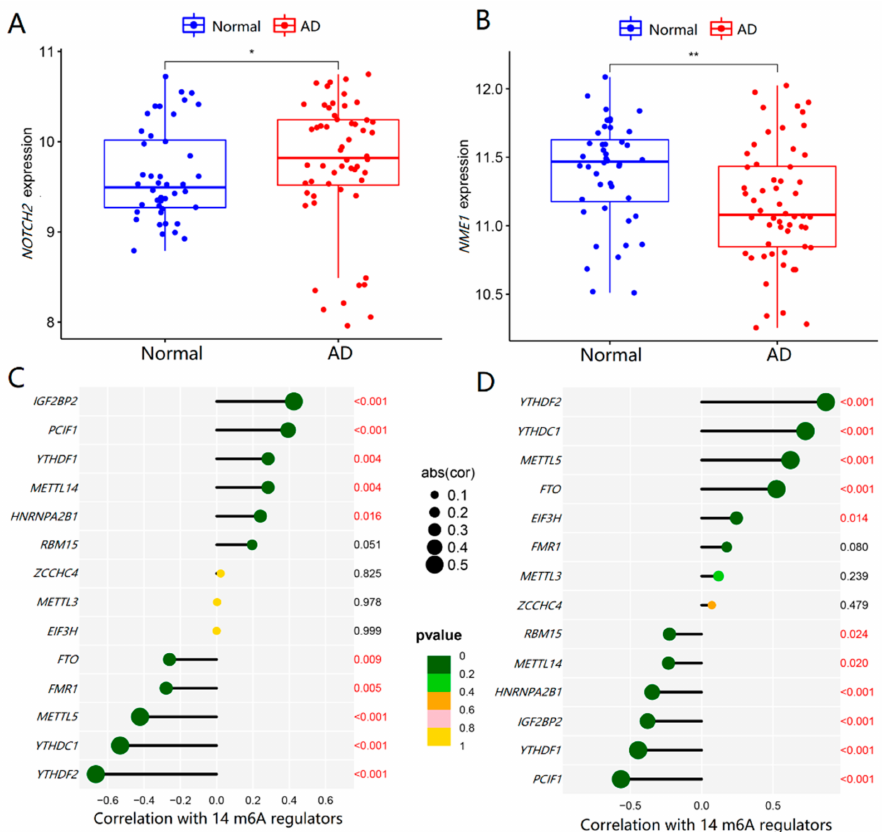
Figure 8. Validation of NOTCH2 and NME1 expression in AD and their relationships with m6A regulators. ( A , B ) The t -test was conducted to analyze the differences in the expression of NOTCH2 and NME1 between normal controls and AD patients by using the validation dataset GSE122063. ( C , D ) The Pearson’s test was performed to analyze the correlations between NOTCH2 and NME1 and m6A regulators. The results with significant differences were marked as * p < 0.05 and ** p <